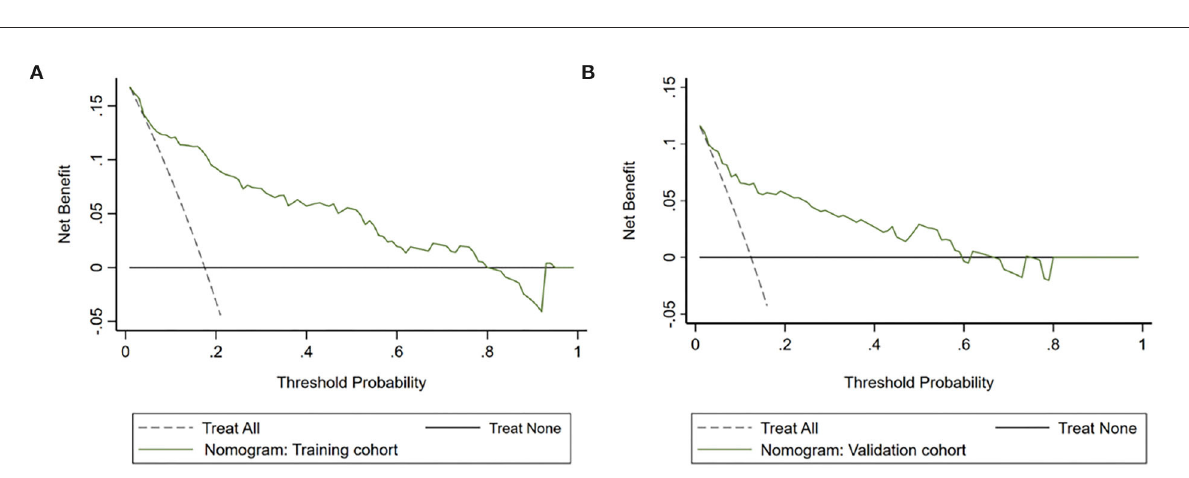
FIGURE5 Decision curve analysis (DCA) of the nomogram predicting HT after intravenous thrombolysis in the training cohort (A) and the validation cohort (B) . The x -axis demonstrates the threshold probability. The y -axis indicates the net benefit. The black line displays all patients are negative and have no treatment, the net benefit is zero. The dotted line means all patients who accept intravenous thrombolysis will develop HT. The green line indicates the net benefit of the